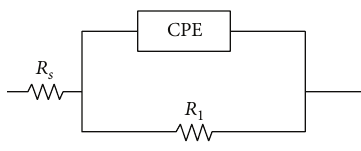
Figure 4: Equivalent circuit of impedance fit.